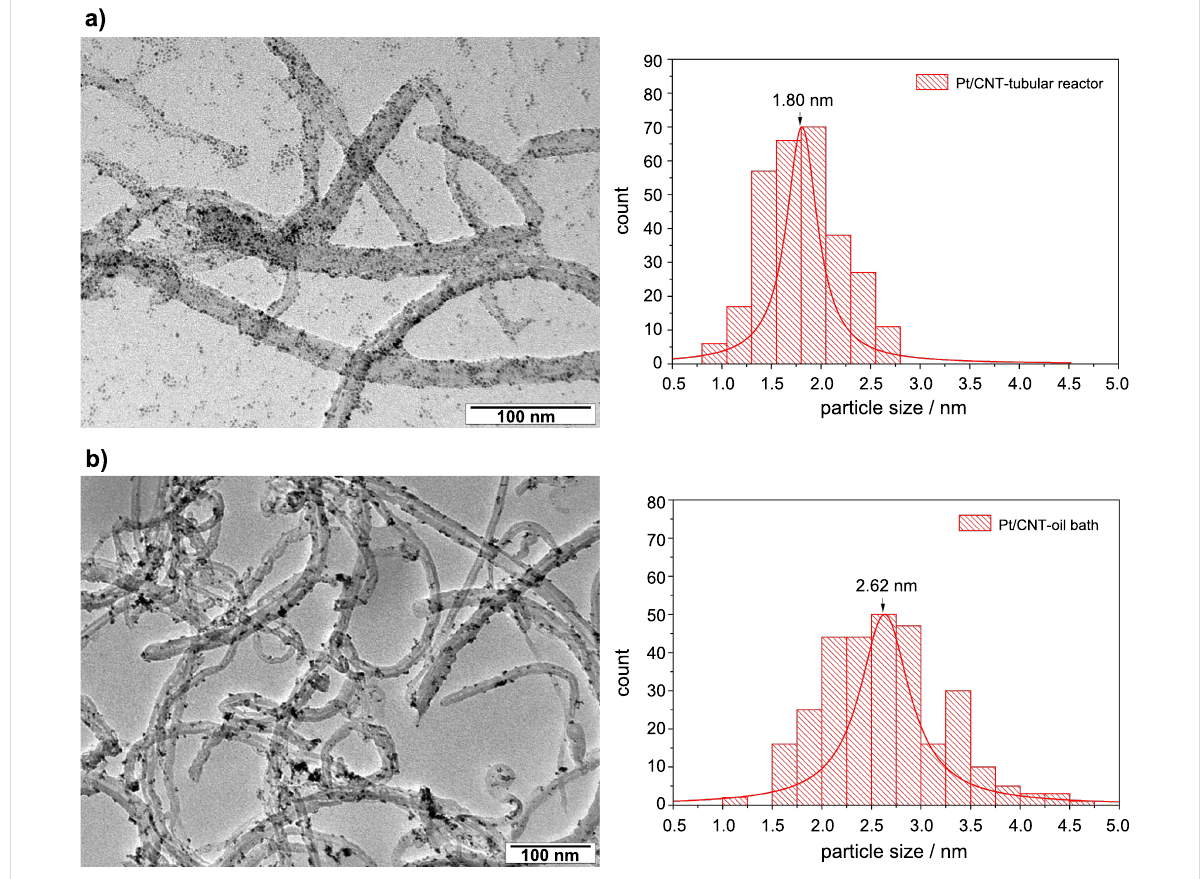
Figure 4: TEM micrographs of catalyst samples: a) Pt/CNT tubular reactor and b) Pt/CNT oil bath.